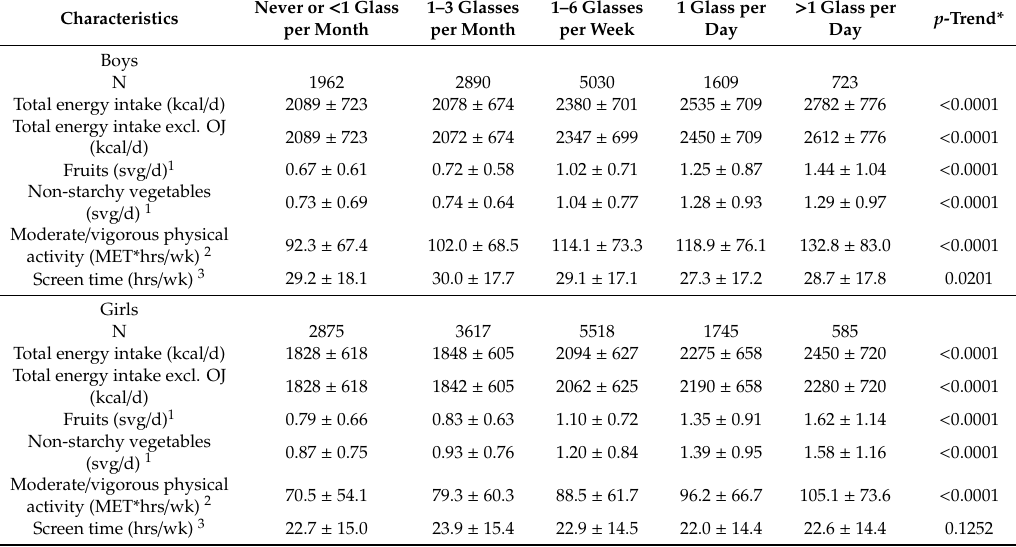
Table 3. Baseline dietary and lifestyle characteristics of the GUTS I and II participants by level of 100% OJ consumption (mean ±